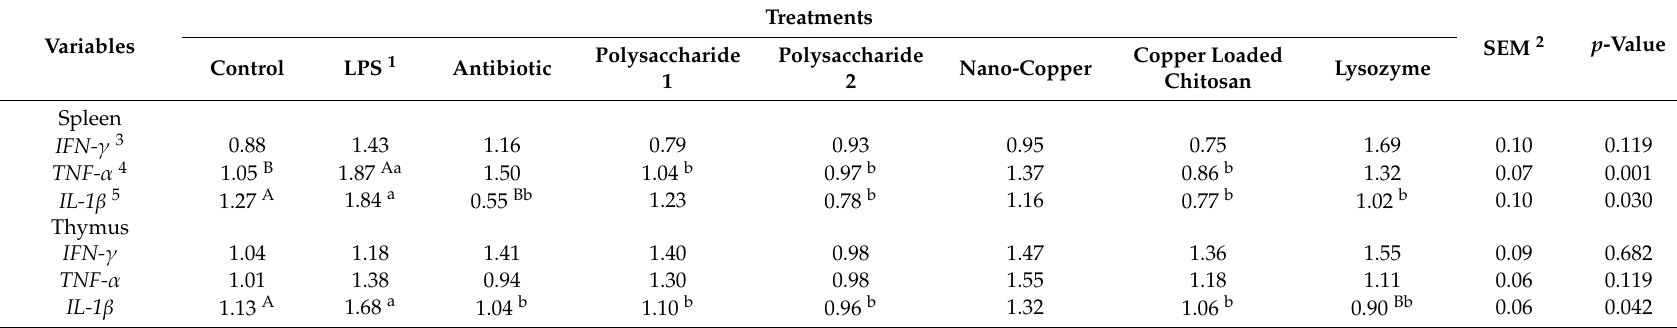
Table 6. E ff ects of mushroom polysaccharide, nano-copper, copper loaded chitosan, and lysozyme on gene expression in spleen and thymus of yellow-feathered chickens challenged with lipopolysaccharides